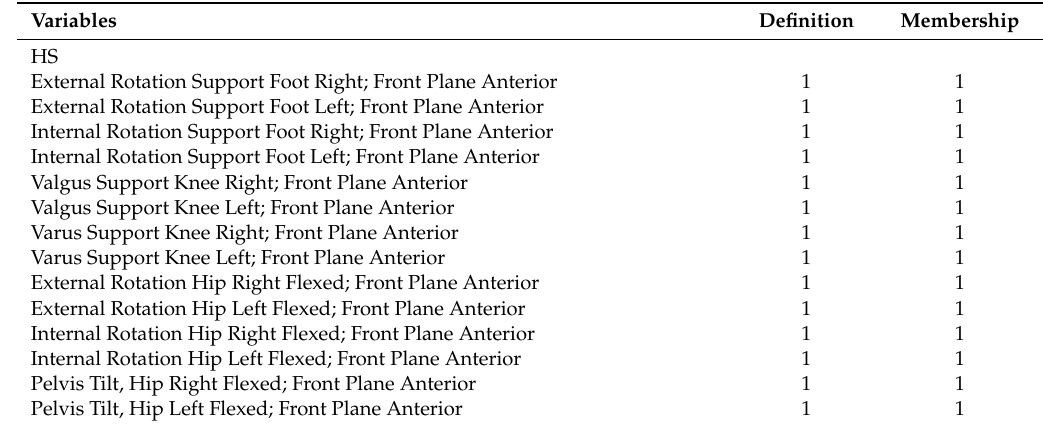
Table 4. Assessment of Aiken V by ten experts of the proposed variables for